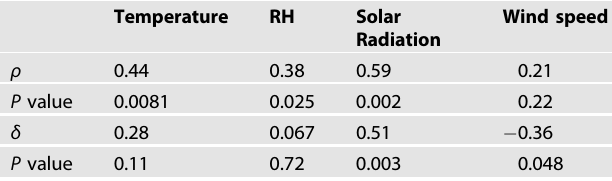
Table 1. Direct and partial Spearman correlation* of E. coli persister switch rate α with an average of 8-h weather